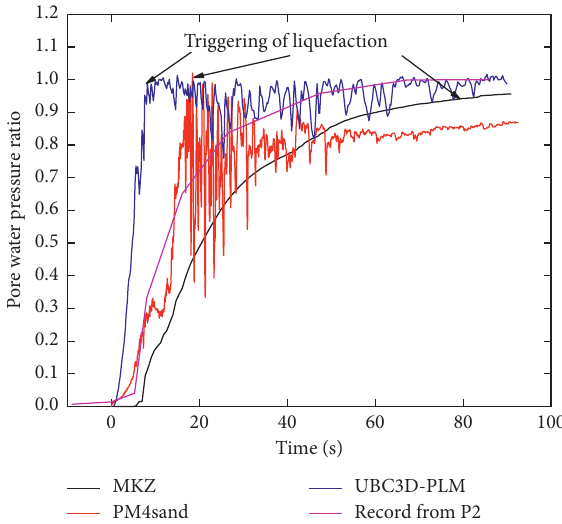
Figure 7: Pore water pressure ratio versus time.